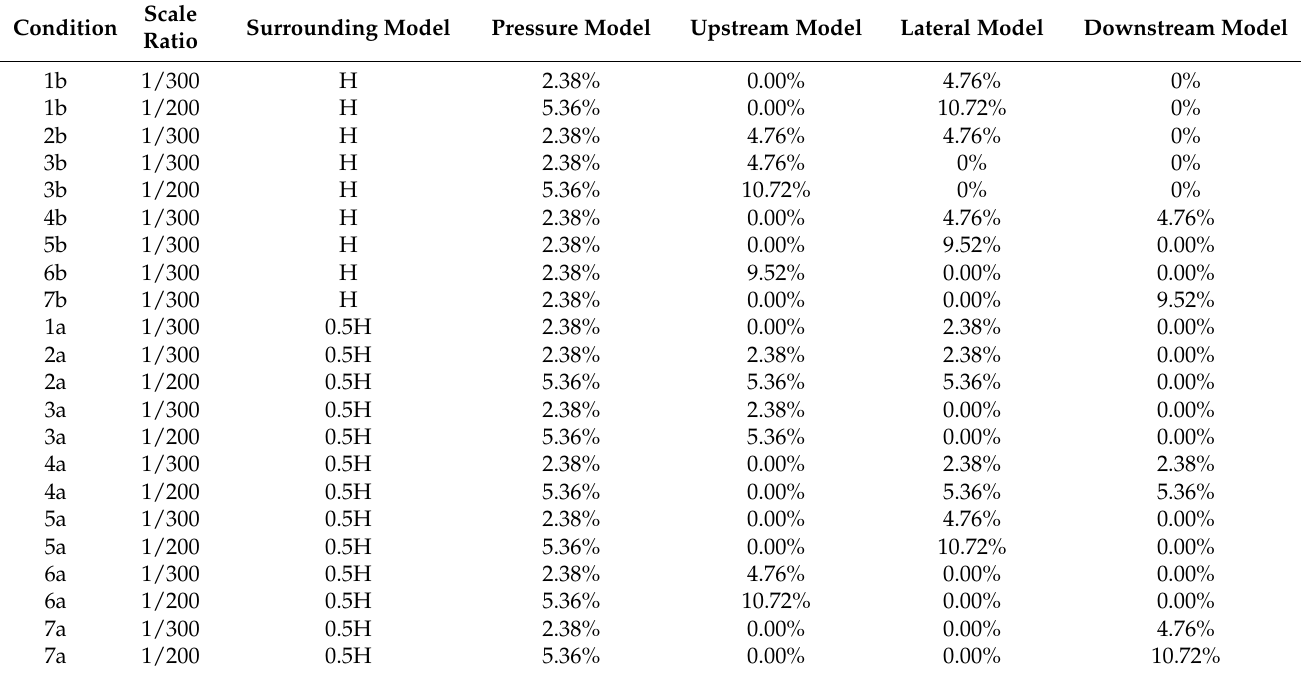
Table 6. The blockage ratio of the target pressure model and surrounding